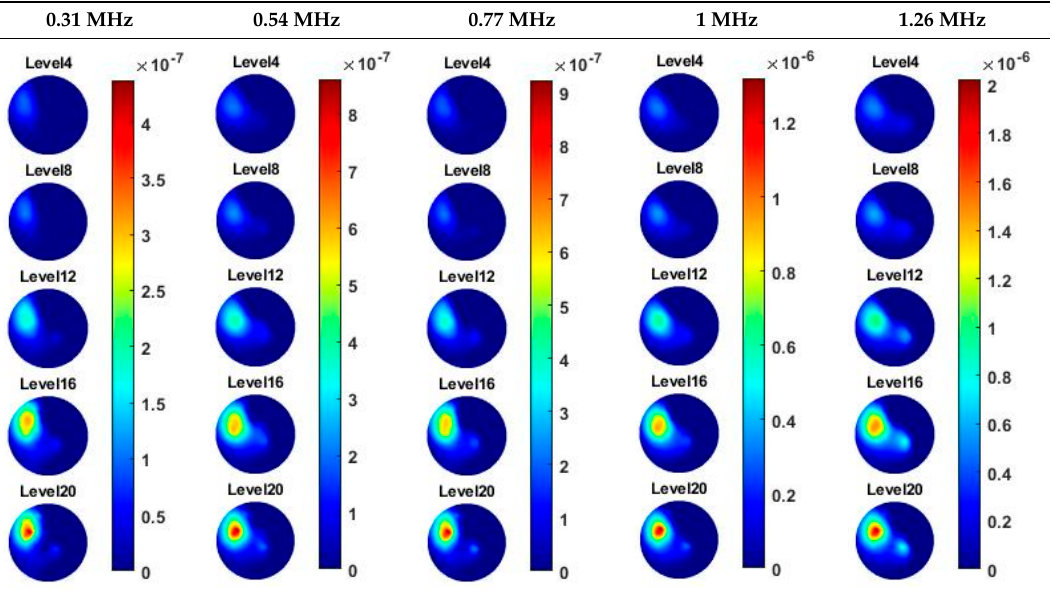
Table 3. Sliced image of horizontal layer for single corn kernel with multi-frequency.